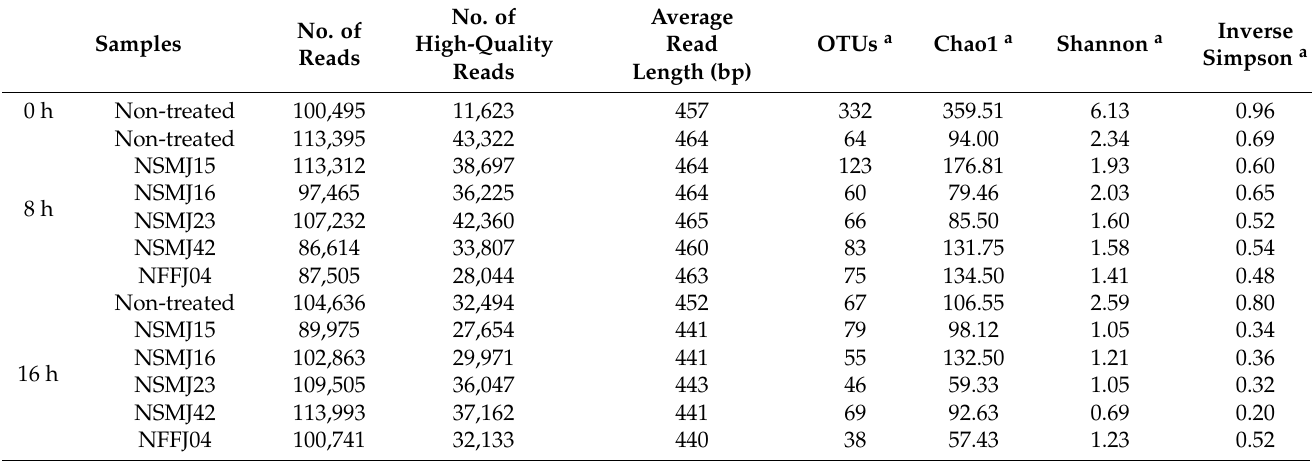
Table 3. Summary and statistical bacterial diversities of Illumina sequencing data obtained from controls (non-treated) and cell free supernatant (CFS)-treated